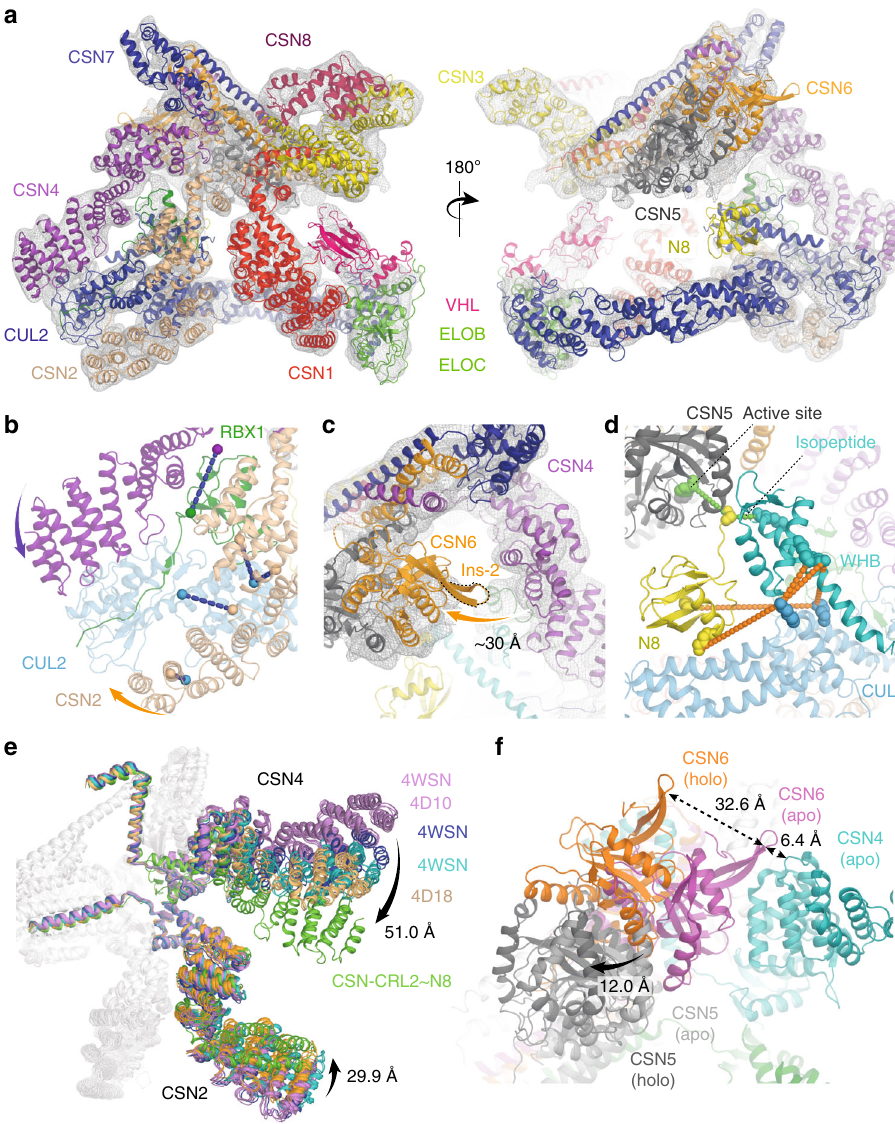
Fig. 1 Structures and interactions of the CSN – CRL2~N8 complex. a The molecular model of CSN – CRL2~N8 fi tted into cryo-EM density (8.2 Å resolution) from front and back views. b Conformational clamping of CRL2~N8 by CSN2 and CSN4. Cross-links shown are between CSN4-RBX1 (CSN4 K200 -RBX1 K105 , purple-green spheres), and four between CSN2 – CUL2 (CSN2 K157 -CUL2 K489 , CSN2 K263 – CUL2 K462 , CSN2 K225 – CUL2 K462 , CSN2 K64 – CUL2 K404 , beige-blue spheres). c View showing ~30 Å separation of CSN6 Ins-2 loop from CSN4 following CRL2~N8 binding. d Modelled position of WHB~N8 using